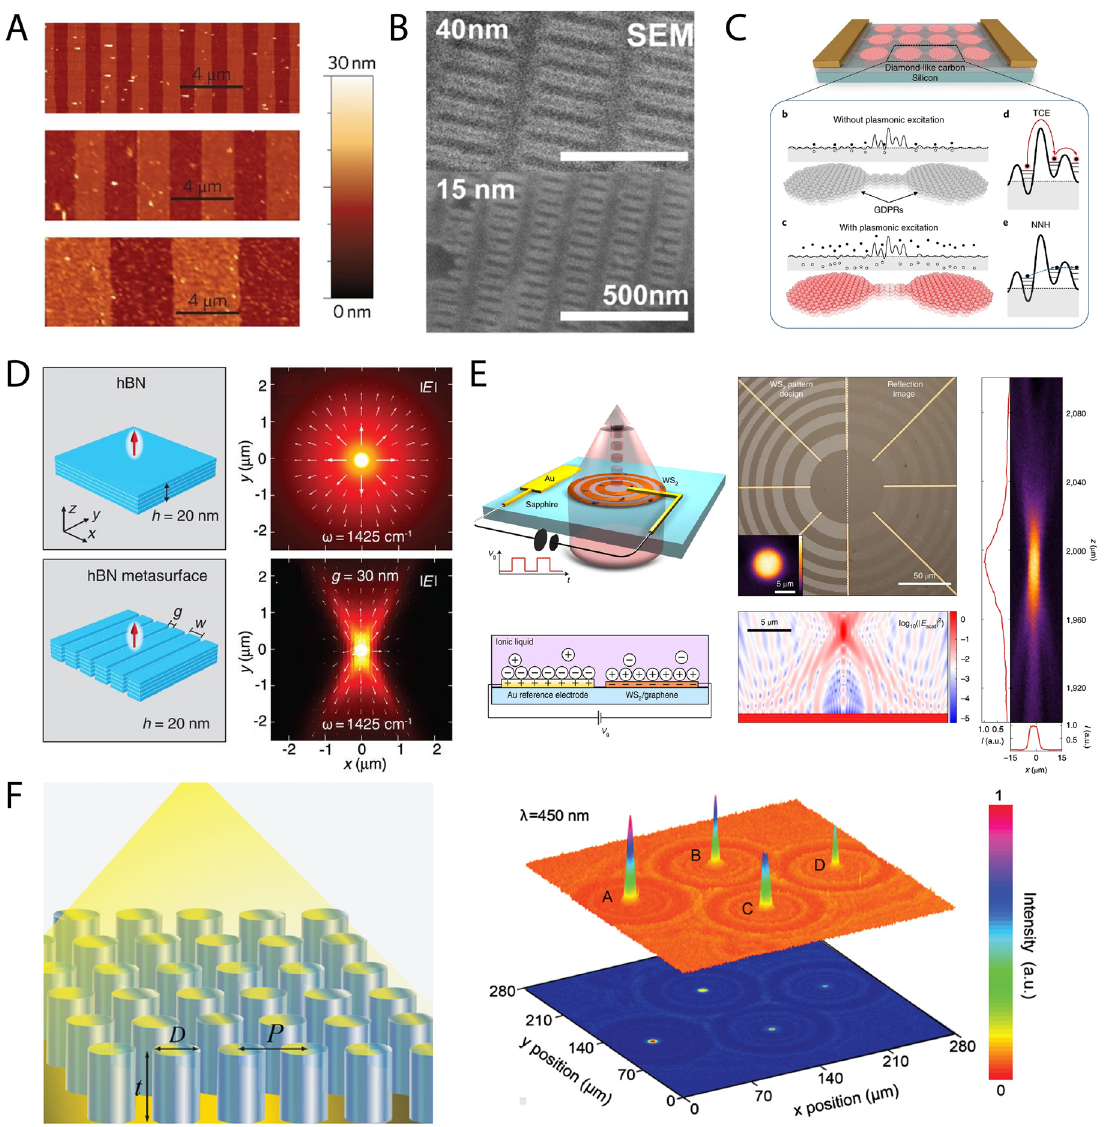
Figure 7: Directly patterning on 2D materials. (A)TheAFMimageofagraphenemicro-ribbonarray,whichservesasaplasmonicresonatorworkinginTHzrange[264].(B)TheSEMimageofa graphene tunable nanoresonator. It can be tuned by varying the back-gate voltage and width of the resonator [265]. (C) The schematic of a grapheneresonatorwhichconsistsofmultiplegraphene-diskplasmonicresonators(GDPRs)andgraphenenanoribbons(GNRs)[266].(D)The schematic of the comparison between a h-BN sheet and a patterned h-BN grating. The electric fi eld distribution of the top surface of the h-BN excitedby anout-of-plane dipole[267]. (E)Theschematicof apatternedWS 2 monolayerthatworks asa metalens[248].(F)The schematicof a h-BN fl ake that is patterned into a pillar array (left) can serve as a set of metalenses (right)